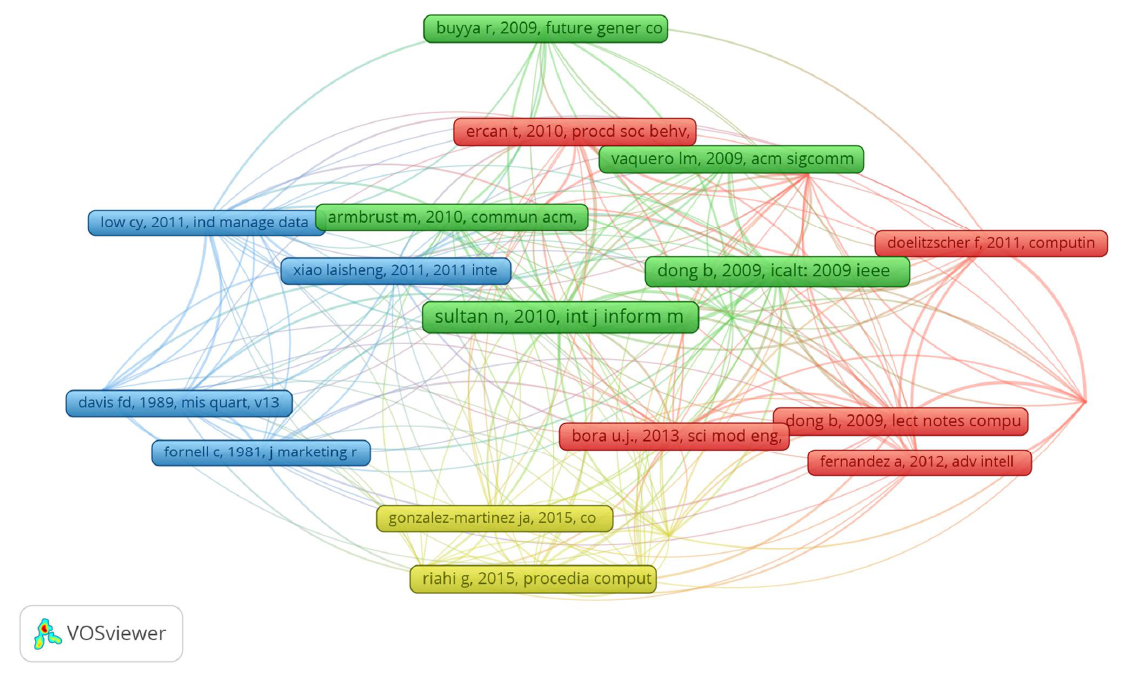
Figure 12. Network visualization map based on text data—Co-citation analysis.